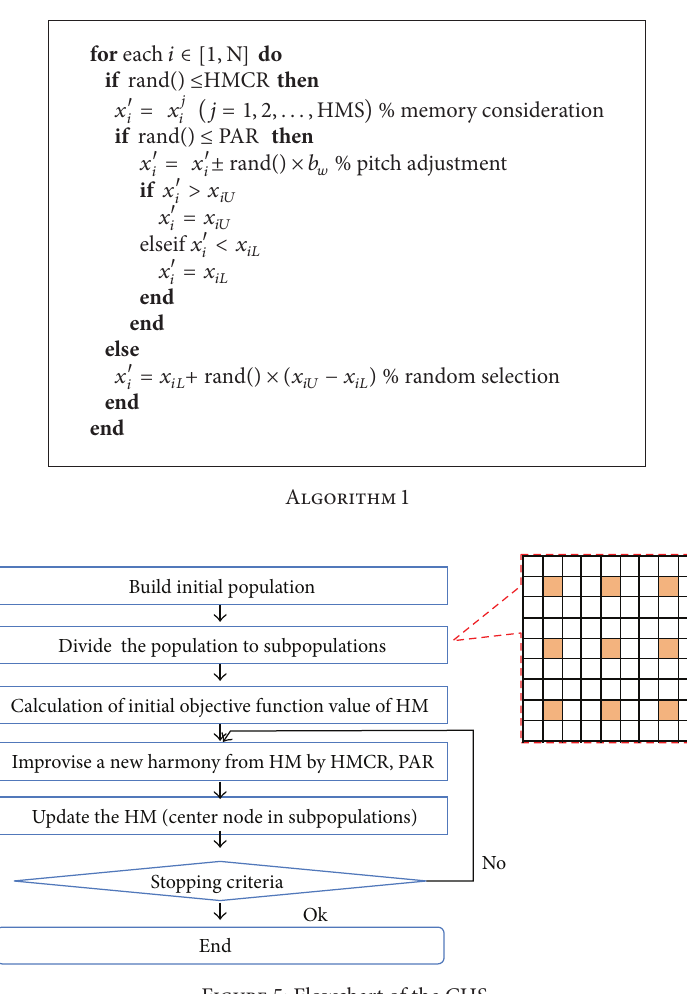
Figure 5: Flowchart of the